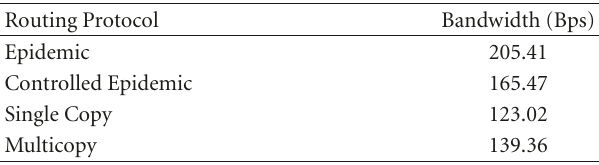
Table 8: Bandwidth